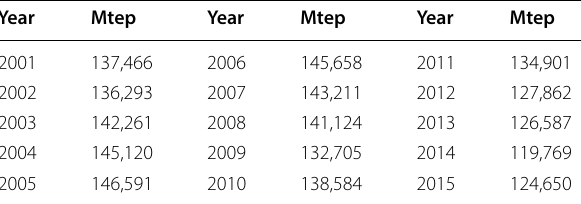
Table 1 Historical trend of final energy consumption in Italy from 2000 to 2015 (Mtep values). Source: Ministry of Economic Development, National Energy Strategy, final consumption from 1997 to 2015, historical